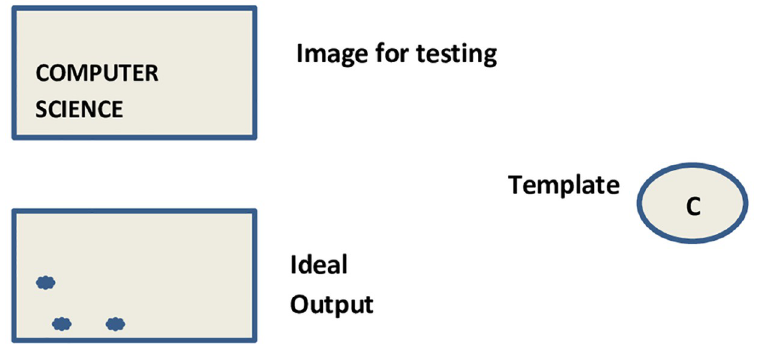
Fig 2. The concept of image